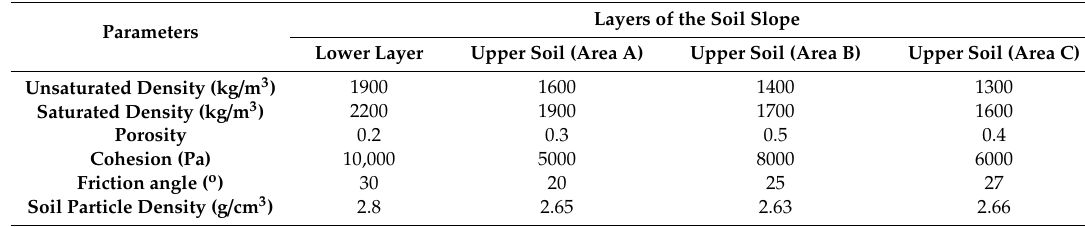
Table 1. Material properties of the layers used in the model.